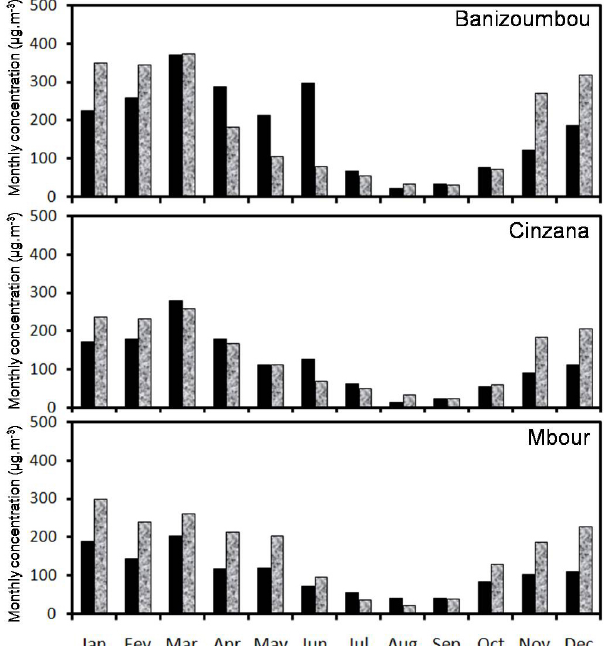
Figure 13. Monthly mean of daily median measured (black) and simulated (grey) surface concentration (in µgm − 3 ) in Banizoum- bou, Cinzana and Mbour from 2006 to 2010.